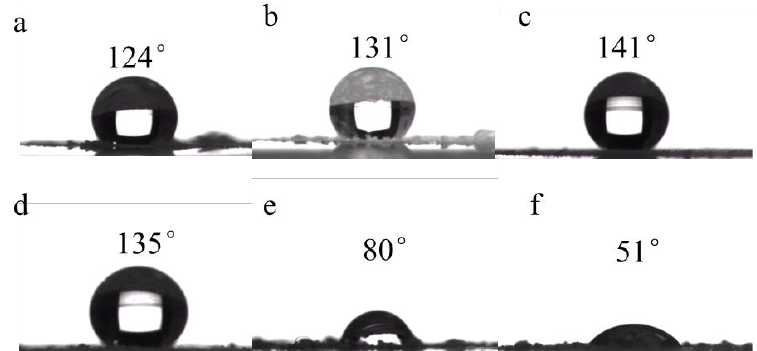
Figure 6. Imaging of water contact angle of xerogels of 1 coated with different solvents. ( a ) DMF/H 2 O (4/1, v / v ); ( b ) acetonitrile; ( c ) DMSO/H 2 O (4/1, v / v ); ( d ) ethyl acetate; ( e ) ethanol; ( f ) methanol.